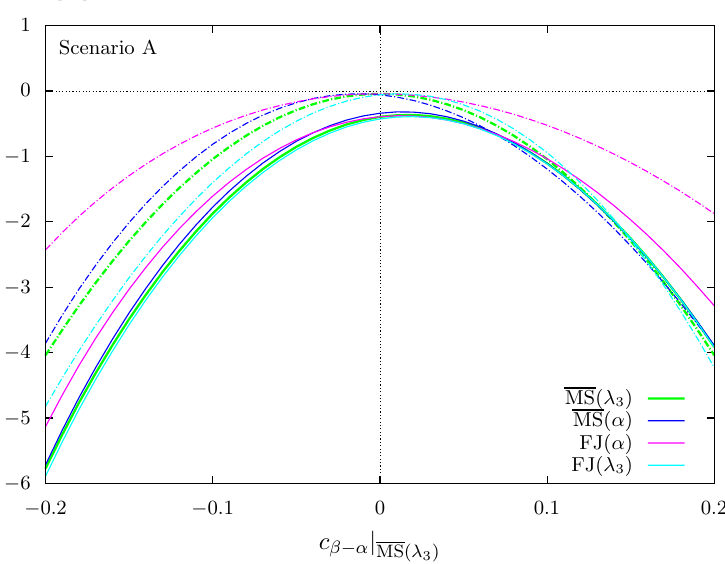
Figure 14 . The relative NLO EW+QCD, QCD, and EW corrections to the h scenario A. The input values are de(cid:12)ned in the MS( (cid:21) 3 ) scheme and converted to the other schemes at NLO (also for the LO curves). De(cid:12)ning the input values in the other schemes leads to qualitatively similar results, see also (cid:12)gure 12. The results computed with di(cid:11)erent renormalization schemes are displayed with the colour code of (cid:12)gure 12.